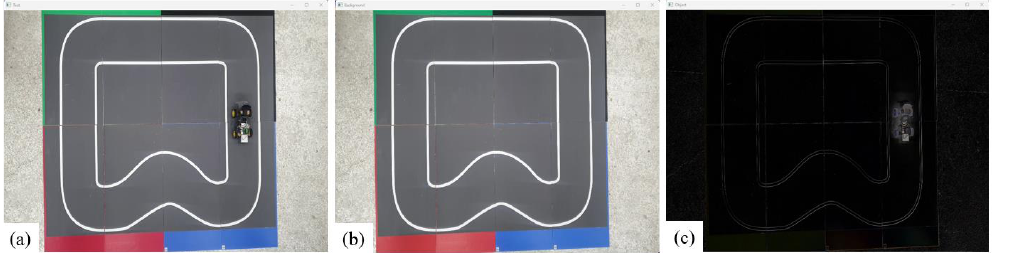
Figure 8. Schematic diagram of the program positioning vehicle coordinates: ( a ) image of a vehicle driving on the track, ( b ) test track background, and ( c ) image of vehicle positioning.